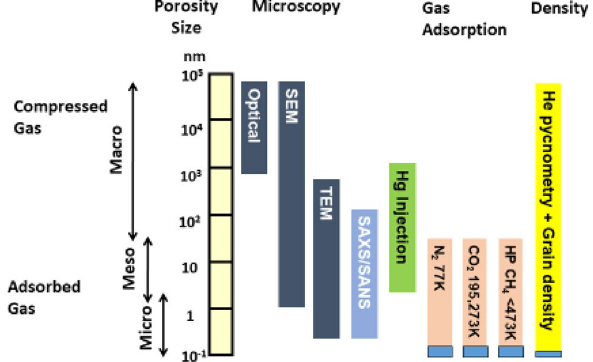
Fig. 6 Measurement techniques and size ranges for characteriza- tion of